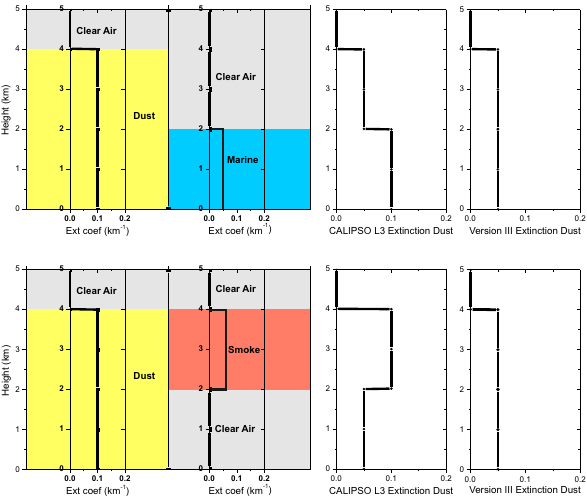
Fig. 7. Synthetic scene examples demonstrating the differences between the averaging procedures followed for the derivation of CALIPSO Level 3 product and in this work for the derivation of Version III product.